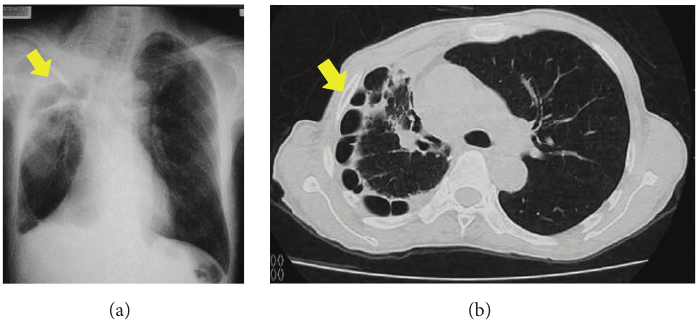
Figure 1: Chest X-ray (a) and chest contrast tomography scan (b) in Case 1. There are interstitial shadows and multiple cysts immediately below the pleura due to shrinkage of the lung, suggesting advanced destroyed lung.